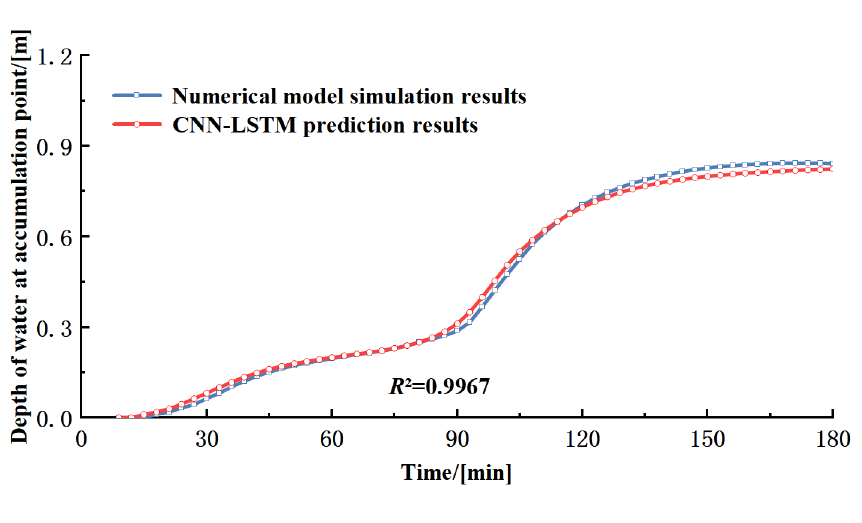
Figure 5. Comparison of simulation results of the design rainfall scenarios based on the storm intensity formula.